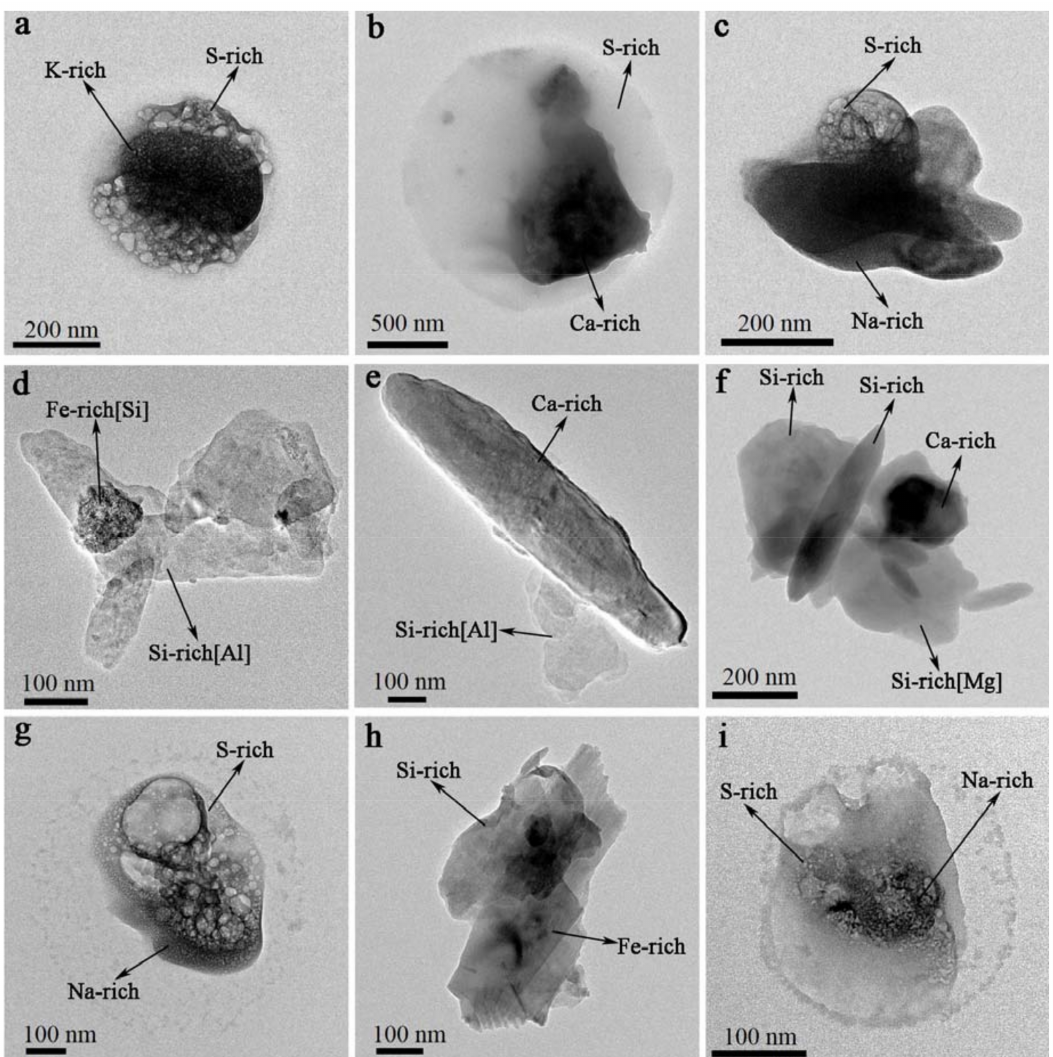
(Figure 8b), the relative number percentages of the S-rich and K-rich particles before and after the dust storm were much higher than those during the dust storm. The relative number percentage of the Si-rich particles during the dust storm was the highest compared with other mineral particles and was significantly higher than that before and after the dust storm. In addition, the Na-rich and Mg-rich particles were not found during the dust storm. The relative number percentage of the Fe-rich particles after the dust storm was higher than that before and during the dust storm. The Al-rich and Ti-rich particles only appeared in the mineral aerosols collected during the dust storm. Therefore, the mineral particles collected before and after the dust storm contained anthropogenic pollutants, such as sulfur- and carbon-containing compounds, which was consistent with the finding that the mineral particles collected in the three stages had different sources.